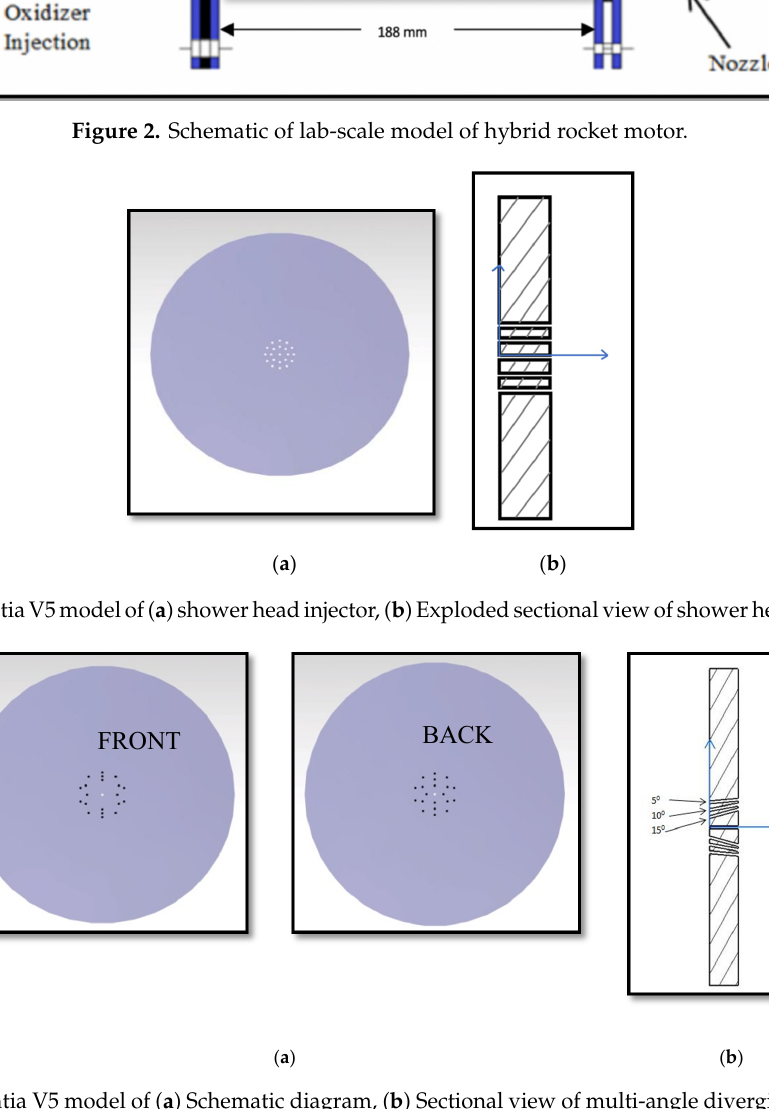
Figure 4. Catia V5 model of ( a ) Schematic diagram, ( b ) Sectional view of multi-angle diverging injector.